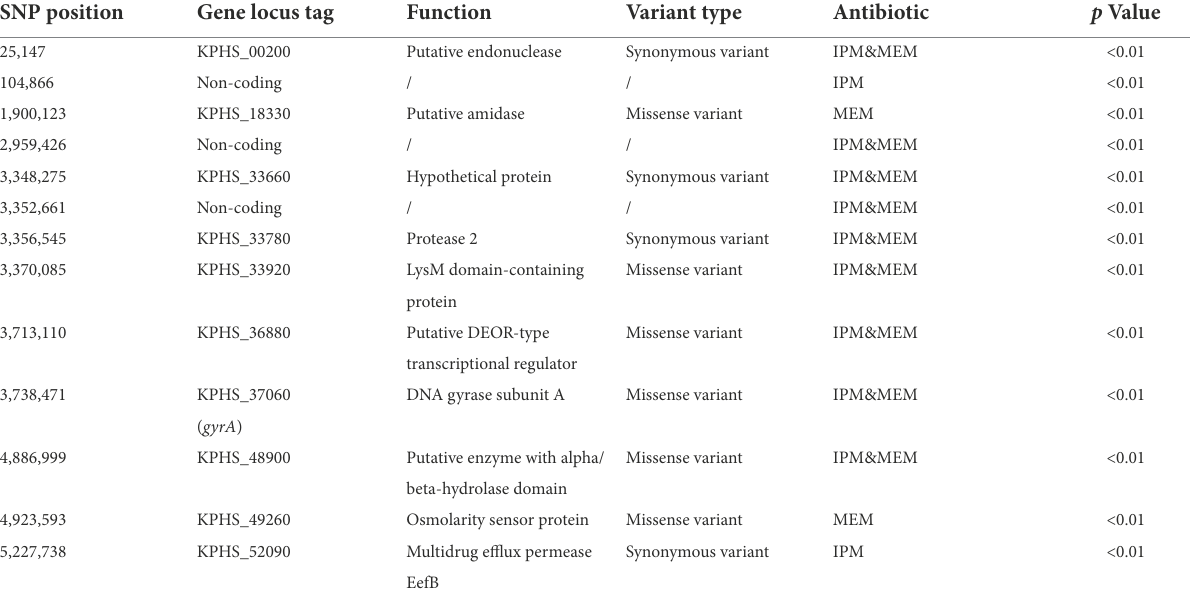
TABLE 3 SNPs related with resistance to two drugs.